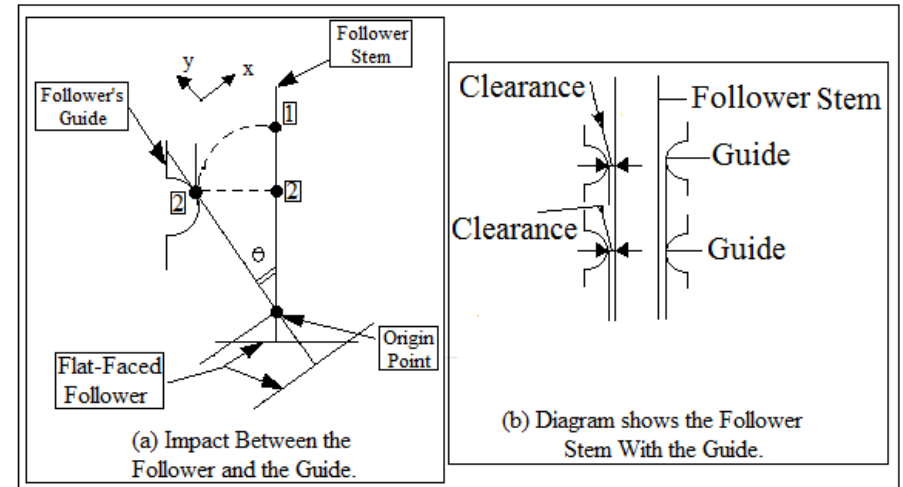
Figure 10. ( a ) Impact between the follower and the guide. ( b ) Diagram shows the follower stem with the guide. the